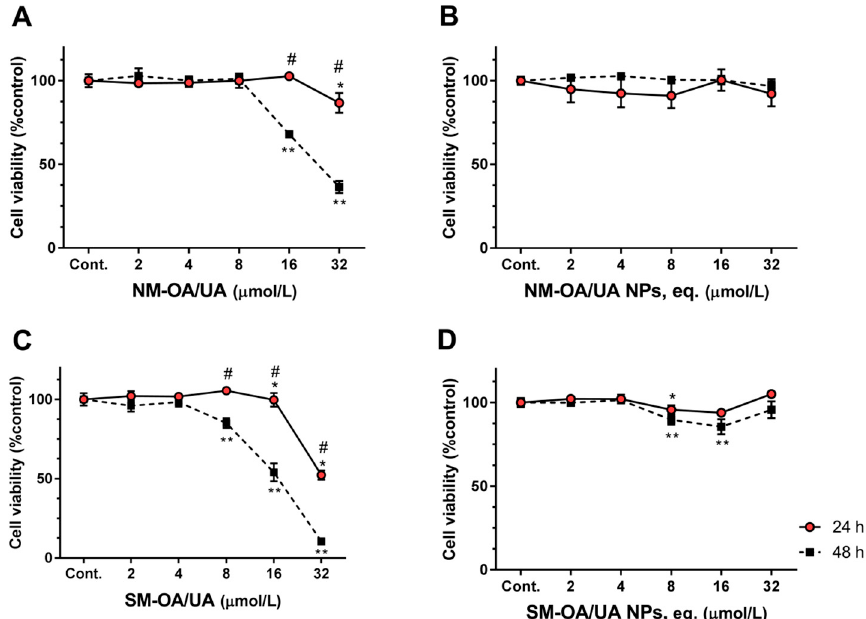
Figure 3. The effect of OA/UA on Caco-2 (human epithelial colorectal adenocarcinoma) cells viability. Caco-2 cells were exposed to NM-OA/UA ( A ), NM-OA/UA NPs ( B ), SM-OA/UA ( C ), SM-OA/UA NPs ( D ), for 24 and 48 h, as denoted. Statistically significant differences, p < 0.05 are denoted with * or **, in relation to respective control at 24 or 48 h, respectively; # denotes statistical differences for incubation periods at indicated concentration. The results are the mean ± S.D. of n = 4.